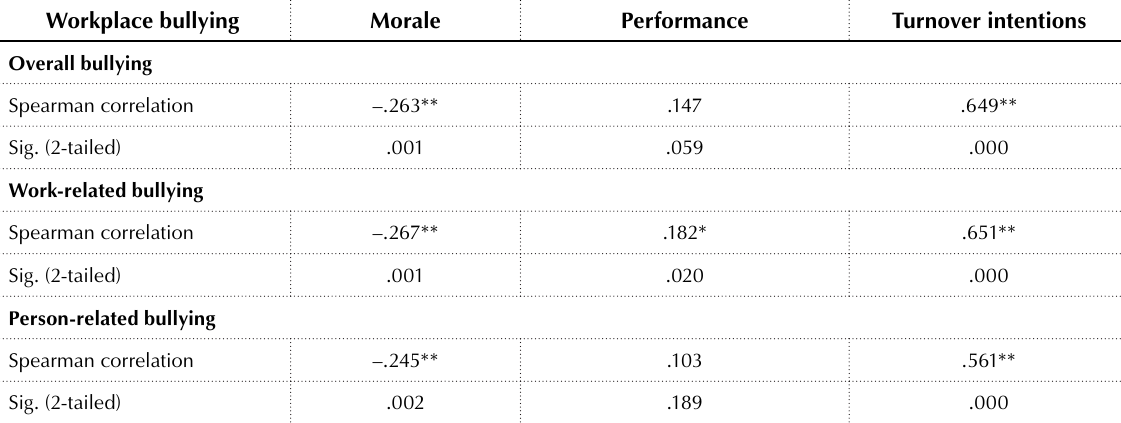
Table 2. Correlation between workplace bullying and morale, performance and turnover intentions